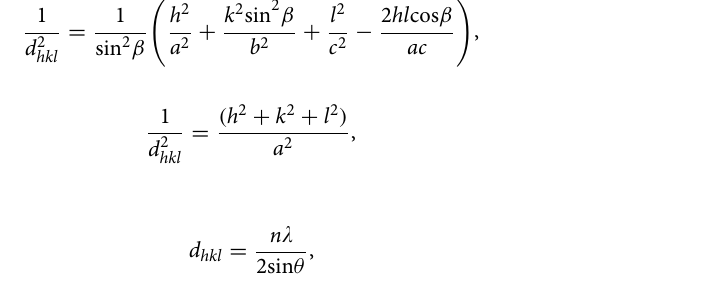
equipped with a field emission gun was used for the morphological and size distribution investigations. Samples for TEM were prepared by dropping the suspension of the Cu-based oxide nanostructure onto a lacey carbon-